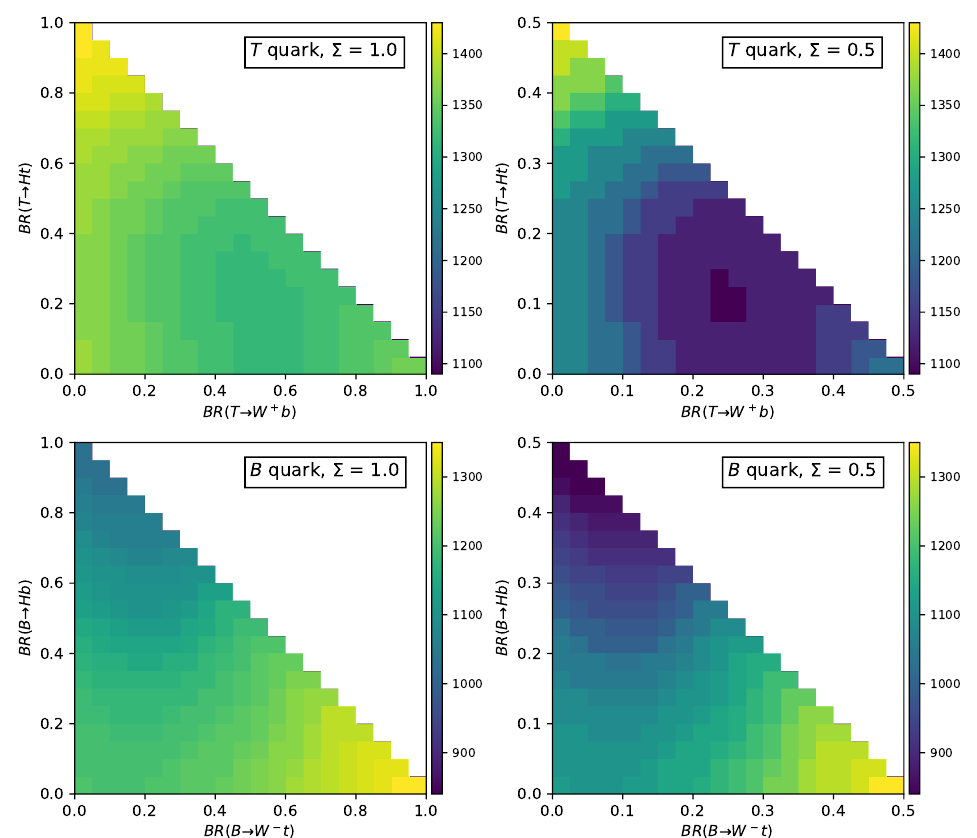
Figure 9 . Left plots: lower bounds for the masses of heavy quarks presented in ref. [57] assuming that the sum of branching ratios into Hq , Zq and W (cid:6) q 0 is (cid:6) = 1. Right plots: corrected lower bounds for the case in which (cid:6) = 0 : 5.